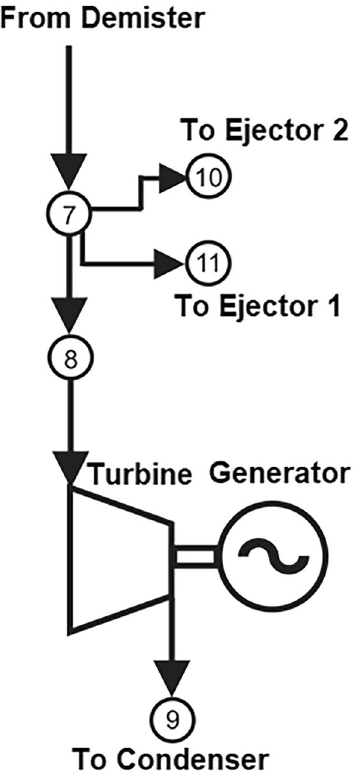
Fig. 5 h–S Diagram for the actual and isentropic processes of an adiabatic turbine. The isentropic process involves no irreversibility and serves as the ideal process for adiabatic devices (redrawn from Cengel